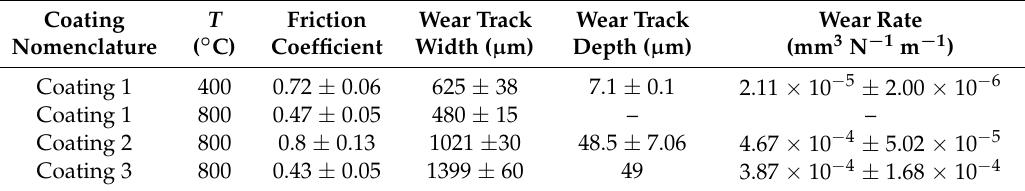
Table 3. Mean values of coefficient of friction, wear track width and depth and wear rates. Coating